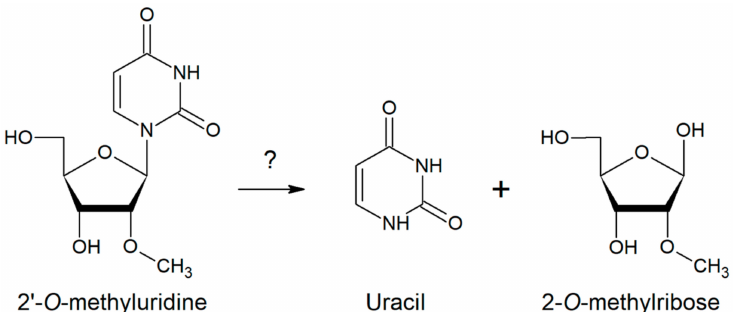
Figure 1. A schematic representation of the chemical reaction catalyzed by the unknown nucleoside hydrolase (represented with a question